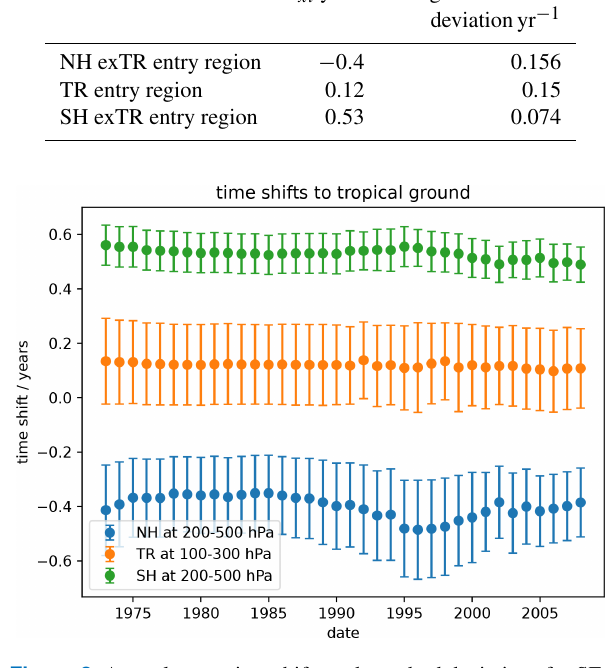
Figure 2. Annual mean time shifts and standard deviations for SF 6 mixing ratio time series at three entry regions, weighted by latitude and pressure. Based on 3-D annual SF 6 model data output from Rigby et al.